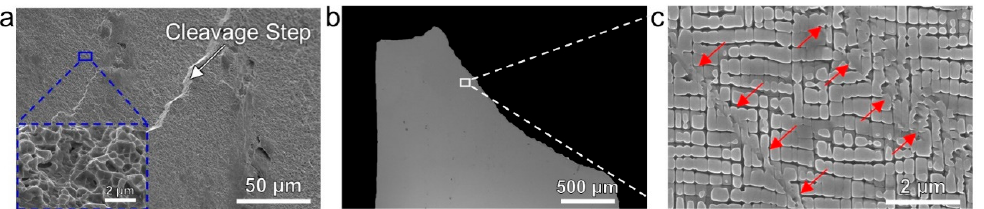
Figure 5. Fracture analysis after the tensile tests at RT. ( a ) Fracture surface of the sample showing the cleavage step (white arrow) and ductile dimples (blue rectangle). The loading direction is out of the plane. ( b ) Side view of the fractured sample. ( c ) Magnified image of the white rectangle in ( b ). The red arrows in ( c ) indicate the shear traces near the fracture surface. The tensile direction in ( b , c ) is vertical.